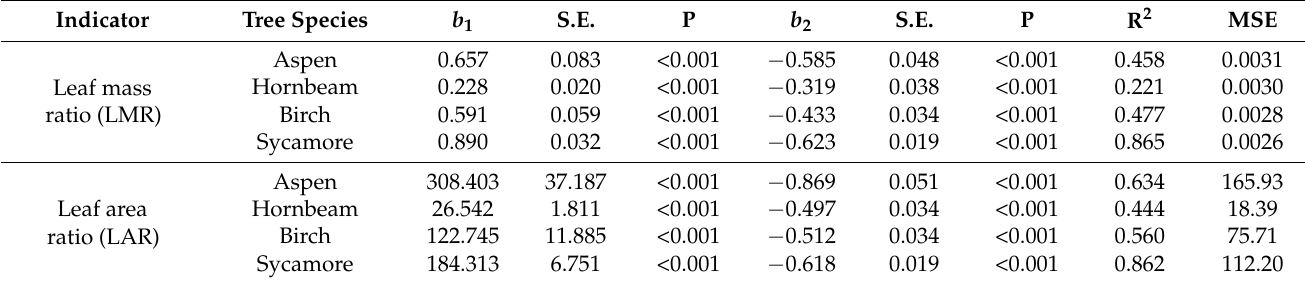
Table 5. Species-specific models for leaf mass ratio (LMR) and leaf area ratio (LAR) based on equation in Figure 1d using diameter at stem base d 0 as a predictor. Meaning of abbreviations is explained in Table